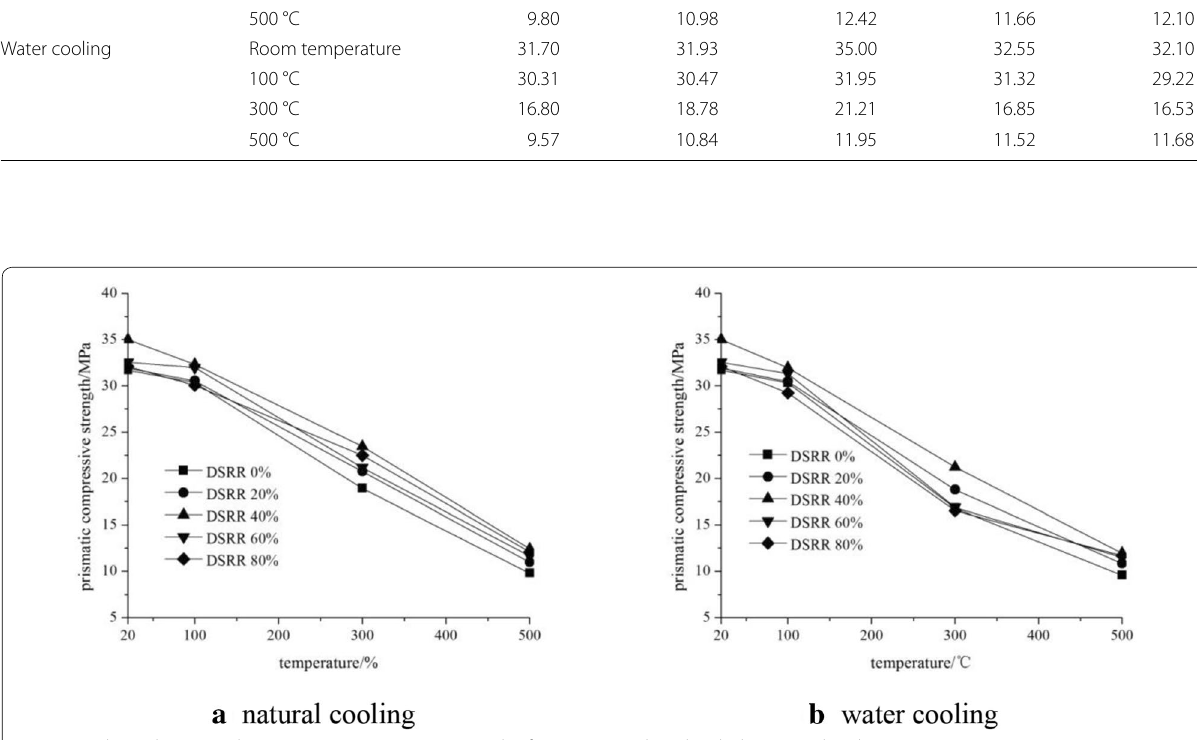
Fig. 10 Relation between the prismatic compressive strength of concrete produced with desert sand and temperature.